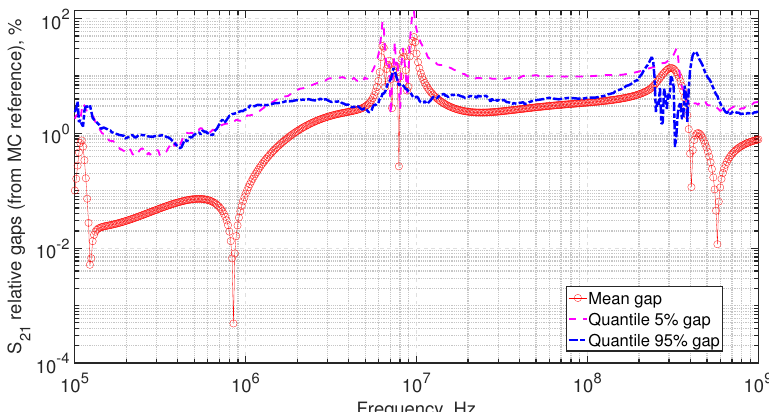
Figure 16. Relative gap between MC reference (100,000 data) and ROC simulations (1000 realizations) from filtering performance statistics: 5%/95% confidence intervals and mean trend from Test case #1/Channel #1.